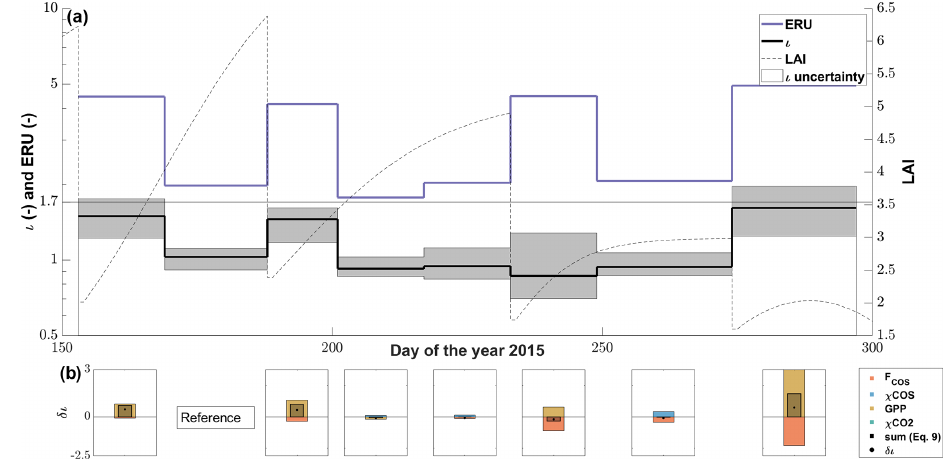
Figure 7. (a) The seasonal cycle of ι (black line) with the 95% confidence interval (gray area) resulting from the FP + model and the midday mean (11:00–14:00 at PAR > 800µmolm − 2 s − 1 ) ecosystem relative uptake (ERU; blue line) using the CO 2 ecosystem flux for the calculation windows ( ∼ 15d adjusted to cuts). The dashed black line depicts the progression of the leaf area index (LAI) of the grassland. (b) The contribution of the drivers ( F COS , χ COS , GPP and χ CO ) to the changes in ι between all calculation windows and the reference 2 period (DOY 169–188) resulting from the linear perturbation analysis compared to the observed change in ι ( δι ).